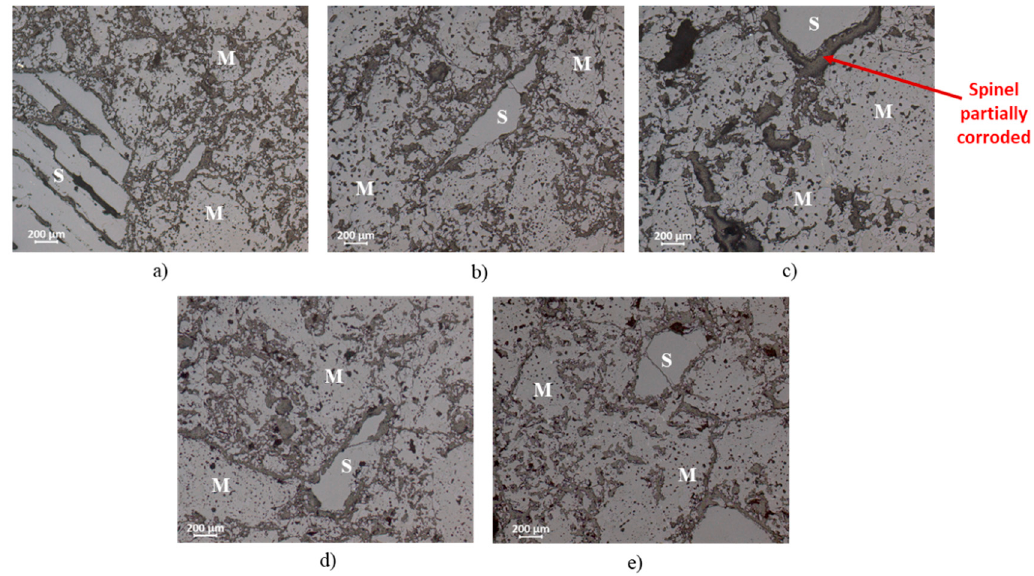
Figure 4. Microstructure of compositions ( a ) A-6, ( b ) A-7, ( c ) A-8, ( d ) A-9 and ( e ) A-10 (M = magnesia, S = fused spinel)— 50× magnification.